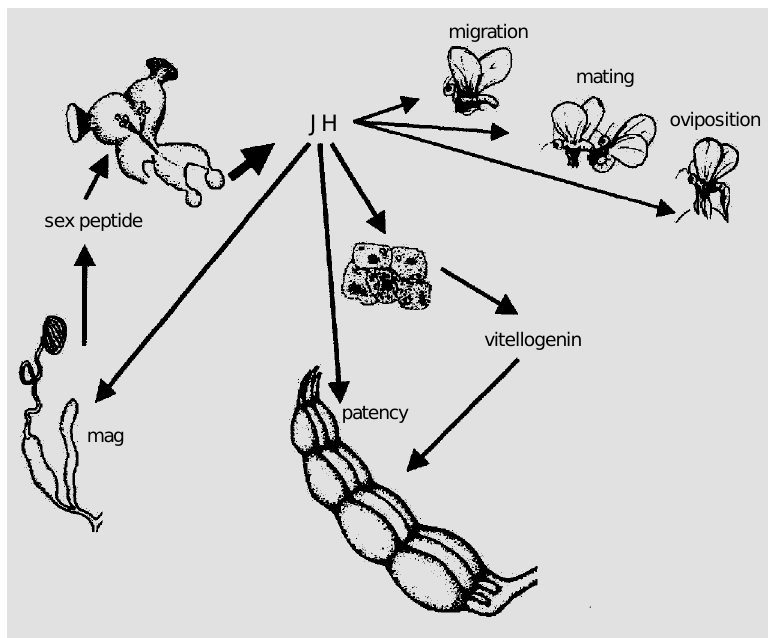
Figure 2 - Schematic representation of the principal functions of juvenile hormone (JH) in reproduction of adult insects. JH released by the corpora allata (CA) modulates behavior associated with dispersal and female reproduction. In the female fat body, JH stimulates vitellogenin synthesis, and in the ovary it facilitates vitellogenin uptake by increasing patency of the follicular epithelium. In males, JH stimulates protein synthesis in the male accessory glands (mag). In some species, a sex peptide produced by these glands is transmitted to the female during mating. This peptide subsequently acts on the CA and modifies postcopulatory behavior in the females and stimulates oogenesis. Obviously, many of these aspects are species-specific and subject to